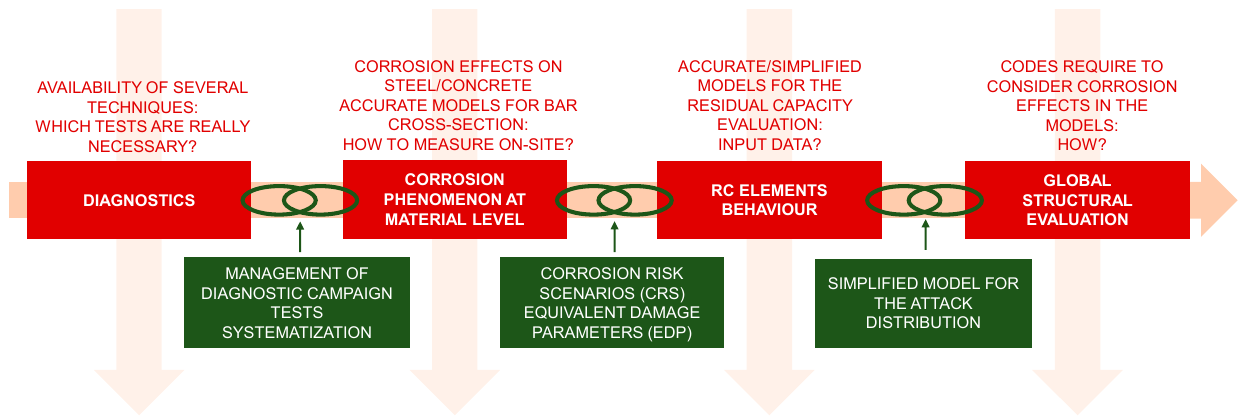
Figure 1. Current practice and state of the art, fragmented into not-interrelated disciplines: major issues inhibiting the modelling of deterioration in current structural analyses (light red arrows, red boxes, and text); identification of required tools to cover the gap between disciplines and to merge them into a new comprehensive approach (green boxes and text).